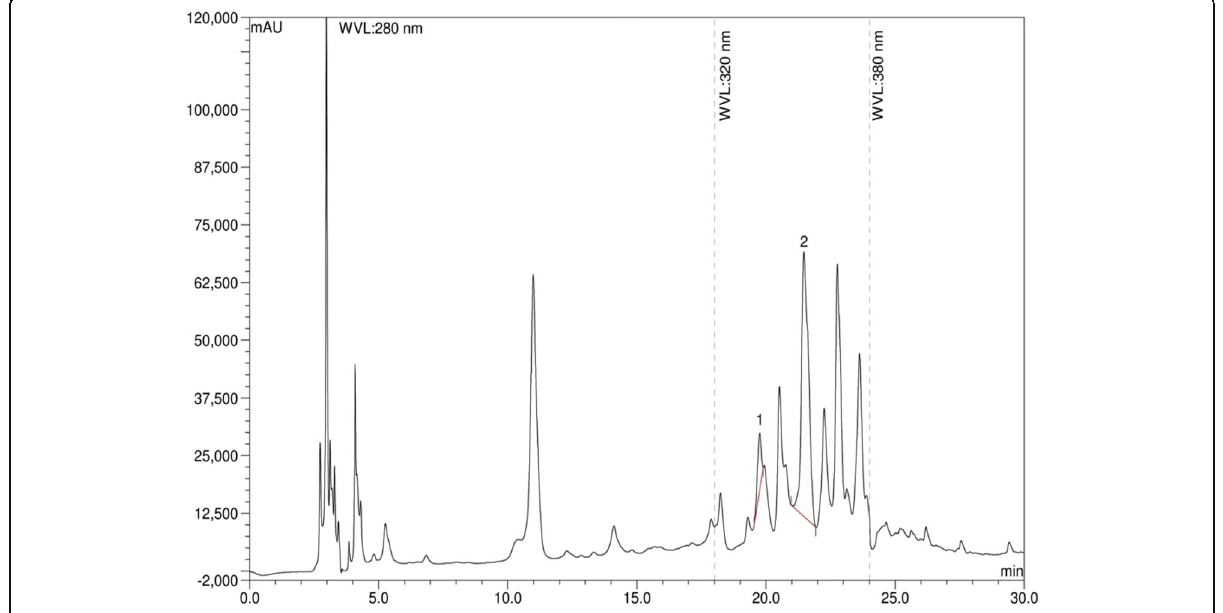
Fig. 2 HPLC chromatogram of ethanol extract of P. sativum (peak 1: p -coumaric acid, 2: ellagic